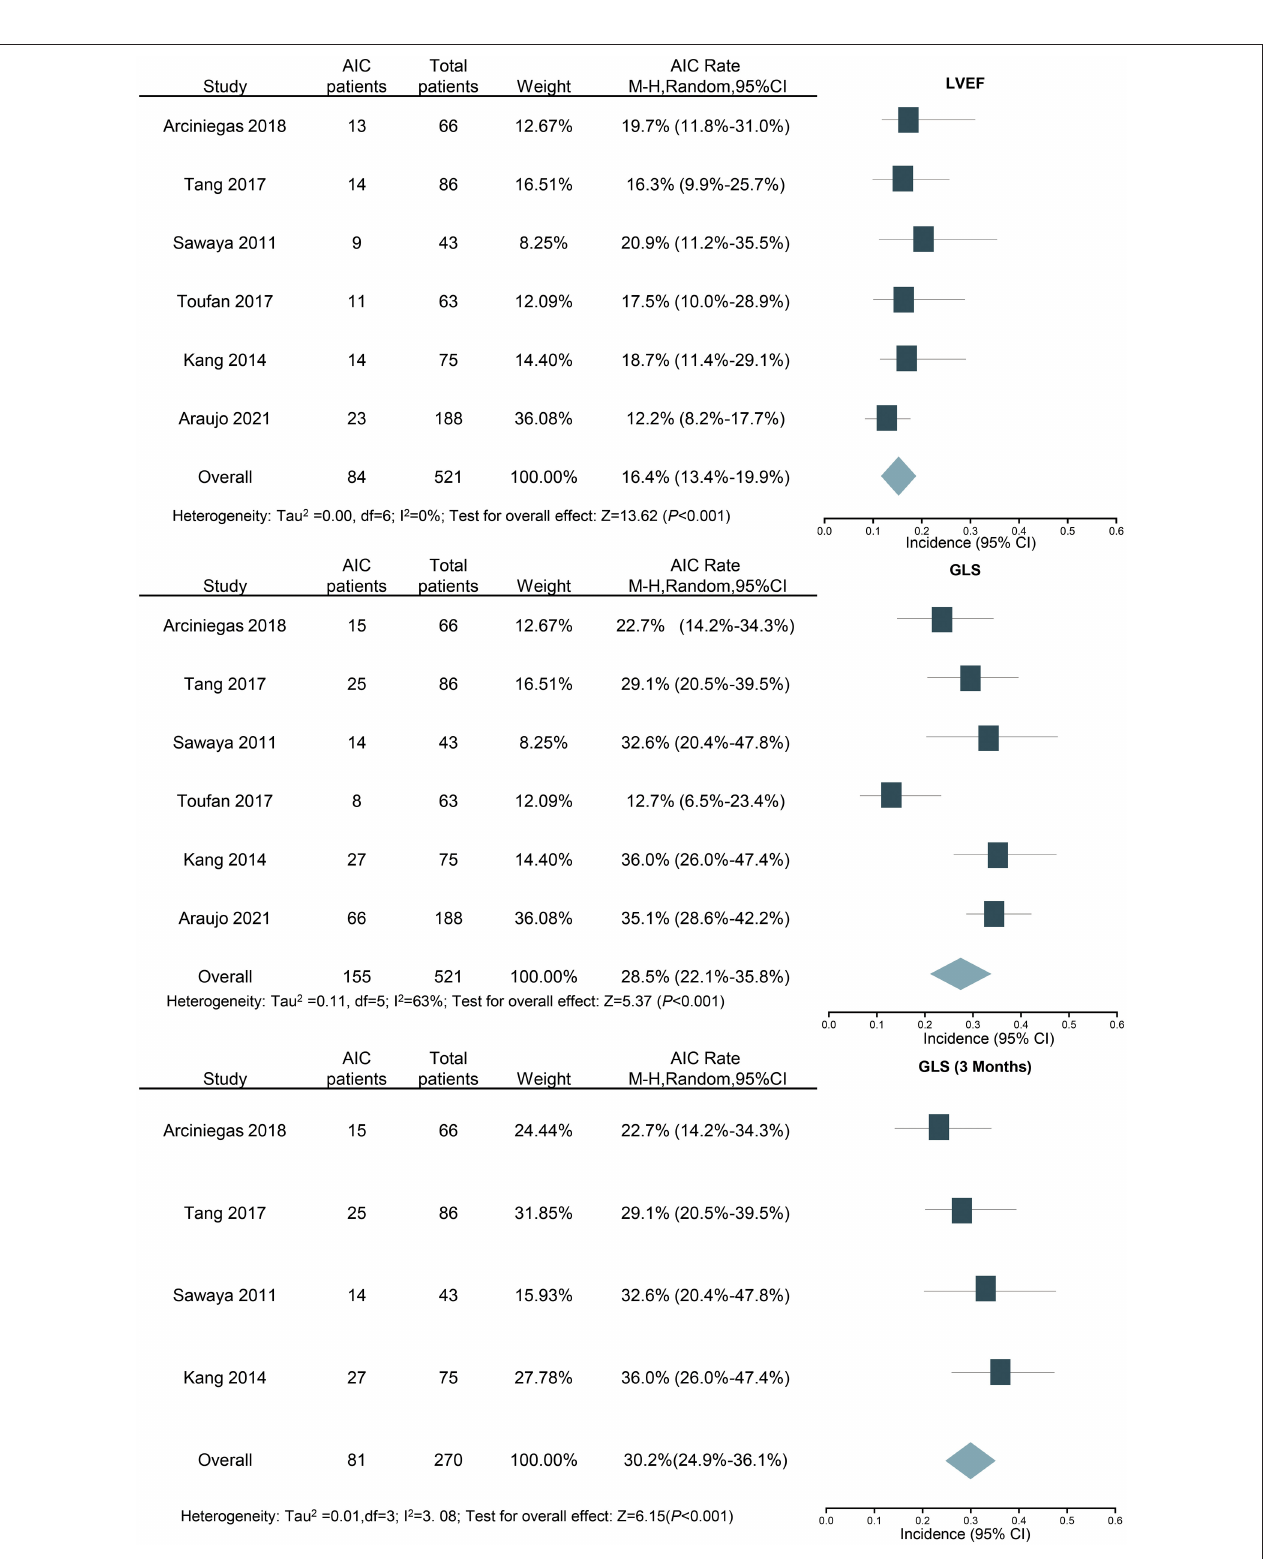
FIGURE 5 | Forest plot for the incidence of anthracycline-induced cardiotoxicity by LVEF and GLS (overall and 3 months). CI, confidence intervals; GLS, global longitudinal strain; LVEF, left ventricular ejection fraction.